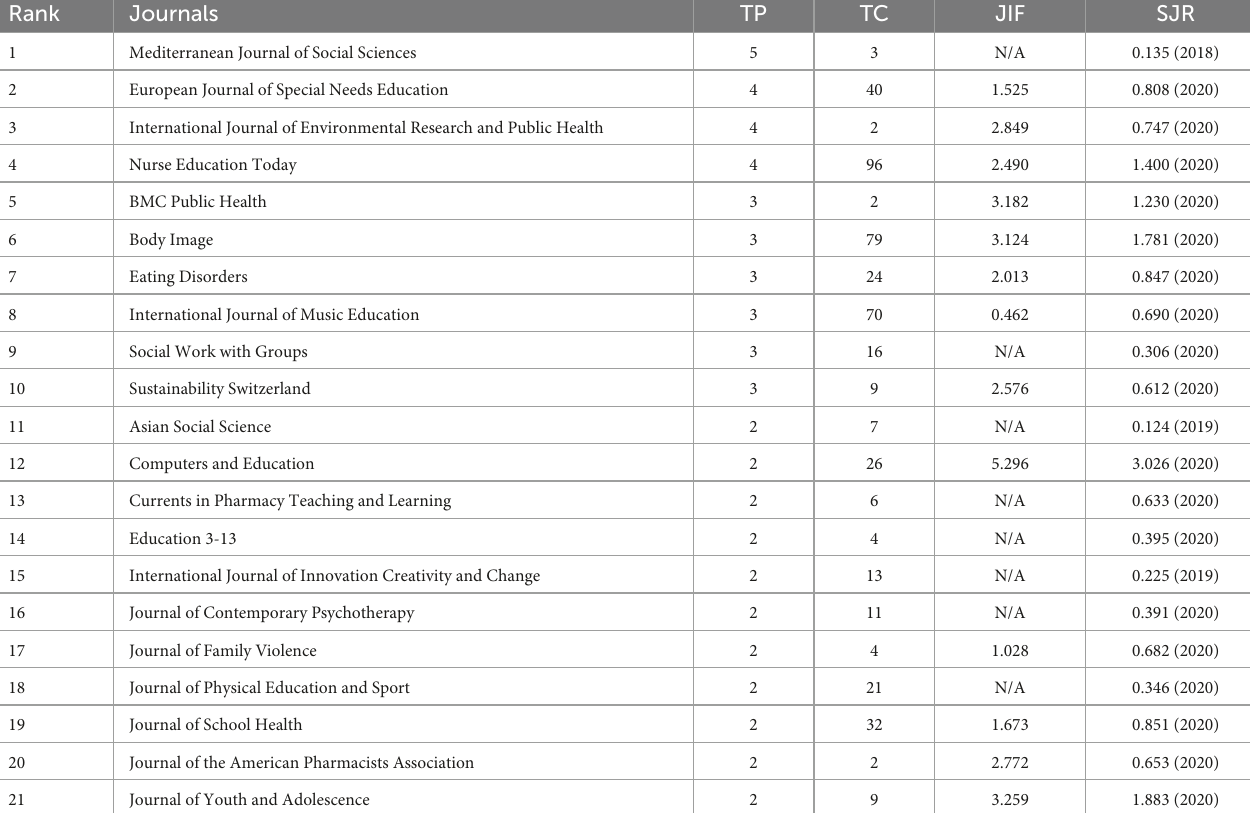
TABLE 4 Distribution of journals that publish articles on curriculum and self-esteem from 2012 to